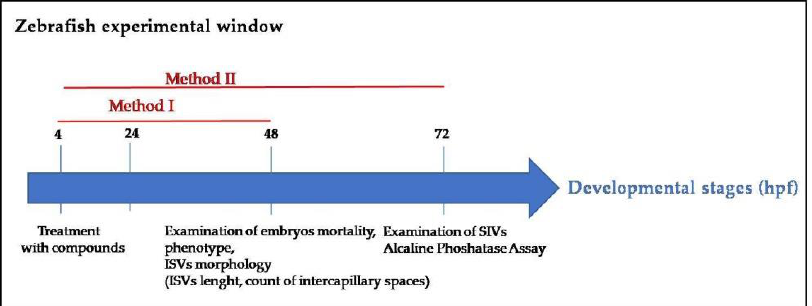
Figure 1. Exposure methods used as experimental plans: The transgenic Tg ( kdrl ;EGFP) zebrafish embryos were treated with the optimal dose (10 µg/mL) of snail extracts (LH, LM, LH3, and LM2) from 4 to 48 hpf (Method I) or from 4 to 72 hpf (Method II). The embryos treated via Method I were used to establish the dose curve and the mortality rate. Embryos treated with optimal doses via Method I were subjected to the analysis.